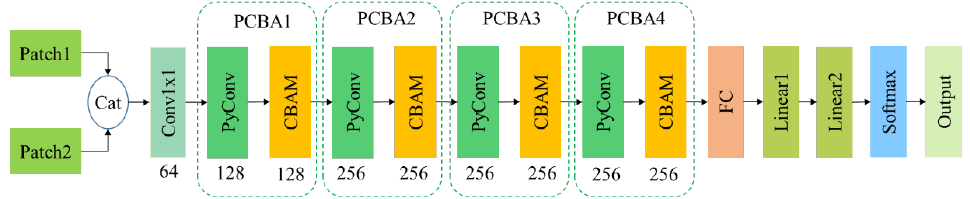
Figure 2. The architecture of the proposed pyramidal convolutional block attention network (PCBA-Net).